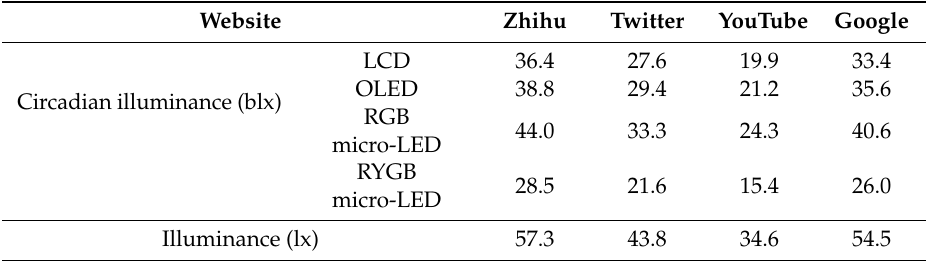
Table 2. Comparison of the circadian illuminance for different displays.